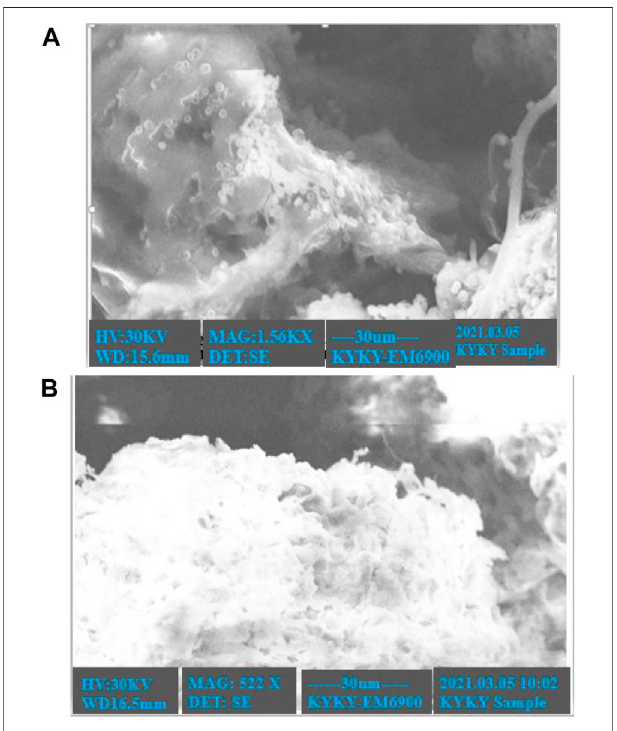
FIGURE 1 | (A) Orange peel before activation and (B) orange peel/ selenium nanocomposite.